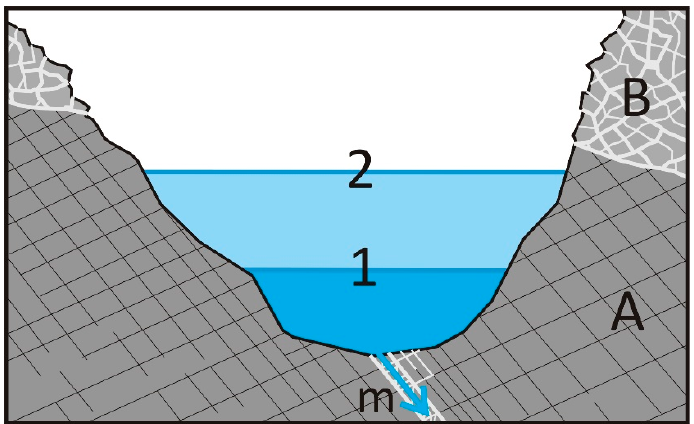
Figure 9. Schematic cross-section along the low Renanchio Stream, downstream of S. Maria: ( A ) Normally fractured rocks; ( B ) loosened bedrock. The Renanchio Stream supplies little MS both in low level 1 (during dry season) and in high level 2 (during flood) using some SW-NE minor scarps (m).